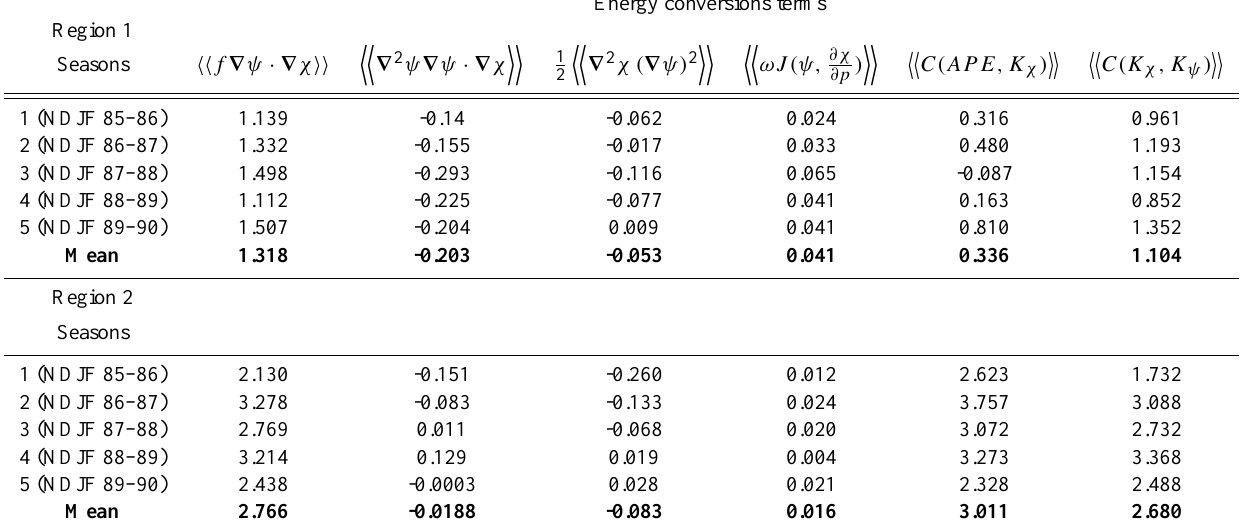
Table 2. Area-time averaged kinetic energy terms for summers in (1) tropical and (2) extratropical domains of South America. Values